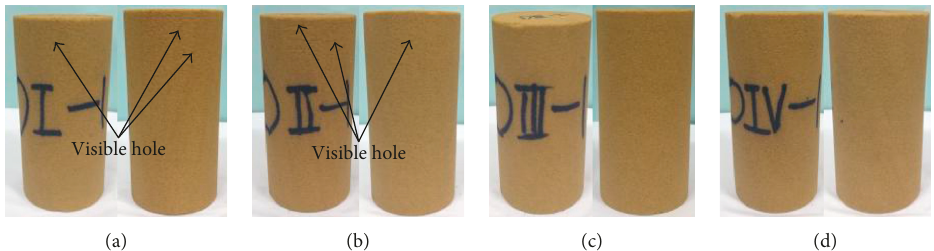
Figure 2: Figures of rock samples immersed in solution with different pH for a time-span of 40 F-T cycles but did not undergo any F-T cycles. (a) pH 2.8, (b) pH 4.2, (c) pH 5.6, and (d) pH 7.0.